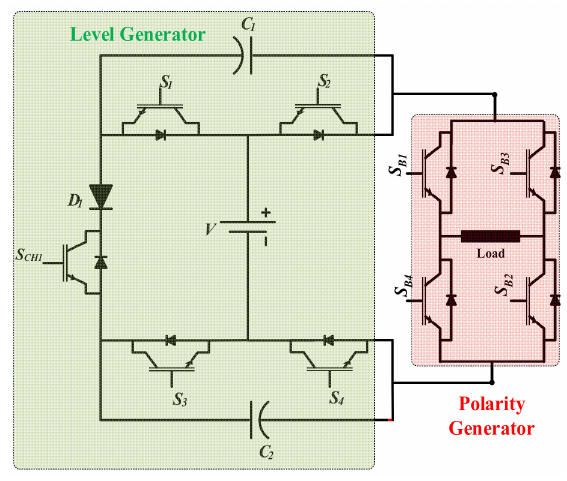
Figure 1. Basic unit of switched-capacitor multilevel inverter. Table 1. Switching states and capacitor